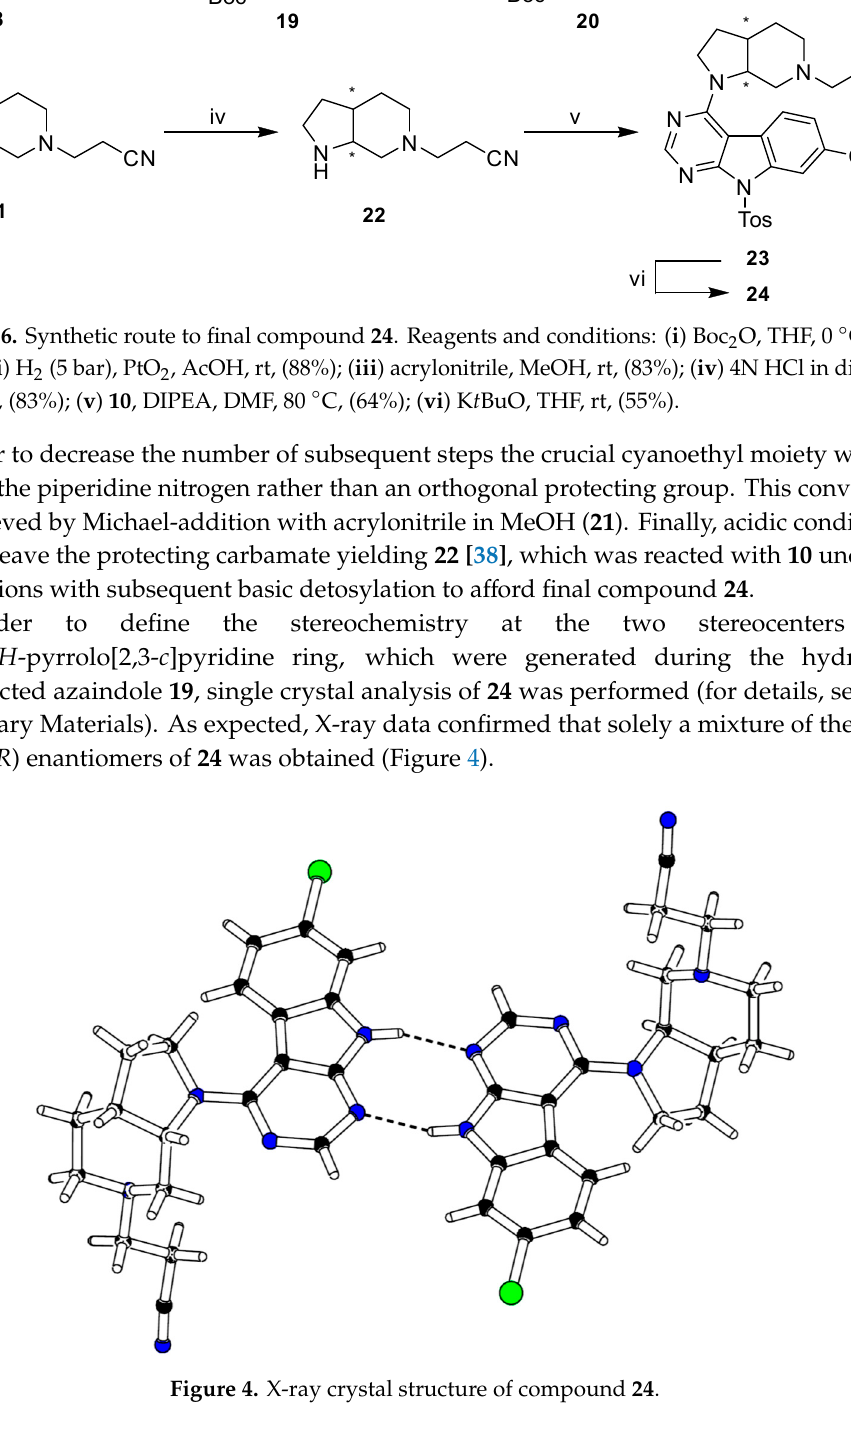
Figure 4. X-ray crystal structure of compound 24 .